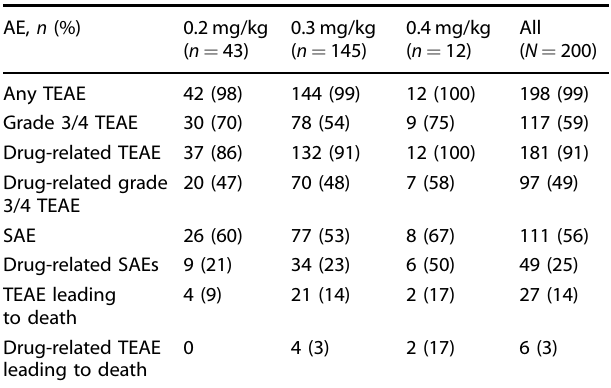
Table 2. Summary of overall safety by